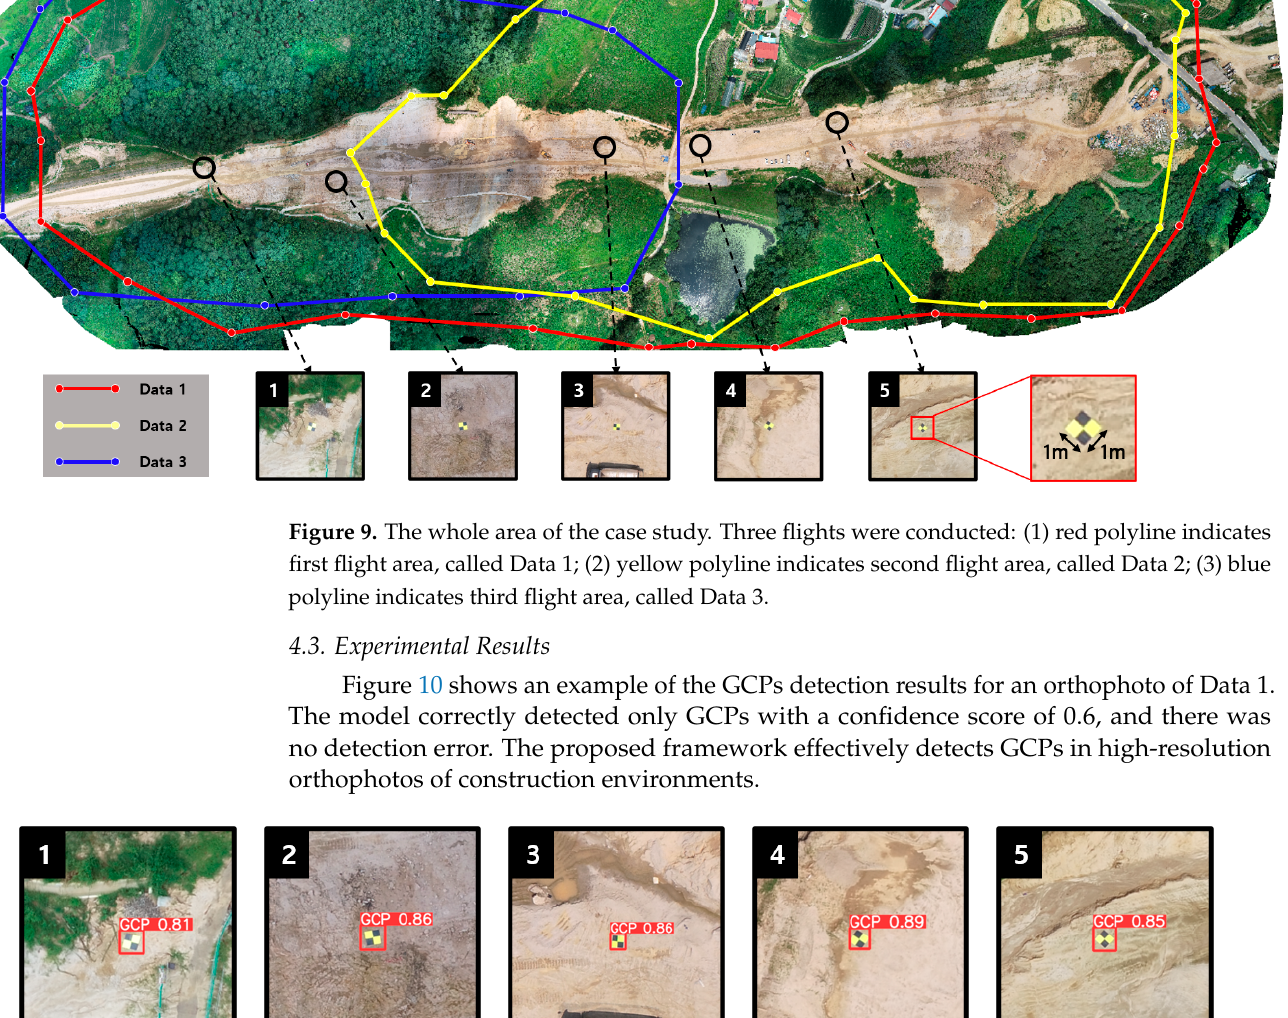
Figure 9. The whole area of the case study. Three flights were conducted: (1) red polyline indicates first flight area, called Data 1; (2) yellow polyline indicates second flight area, called Data 2; (3) blue polyline indicates third flight area, called Data